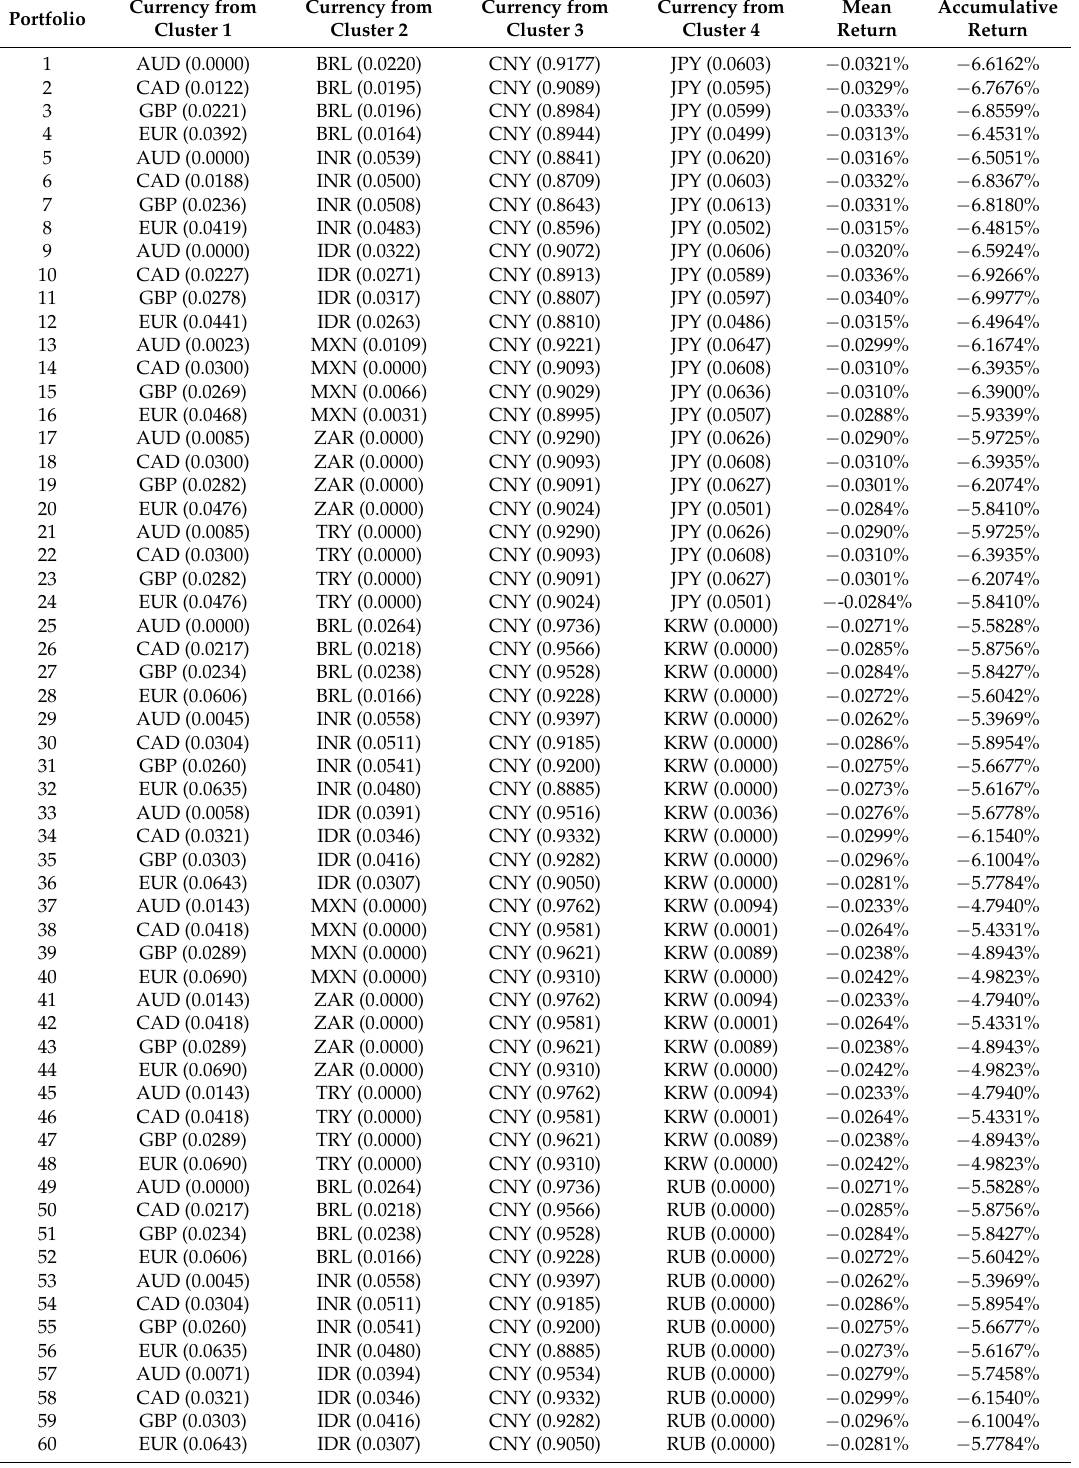
Table A3. Sevent-two portfolios constructed based on our clustering result in Table 7. Notice that for each cluster only one currency is selected. The portfolio weights obtained by Markowitz minimal variance criteria is given in the bracket. In addition, mean returns and accumulative returns are